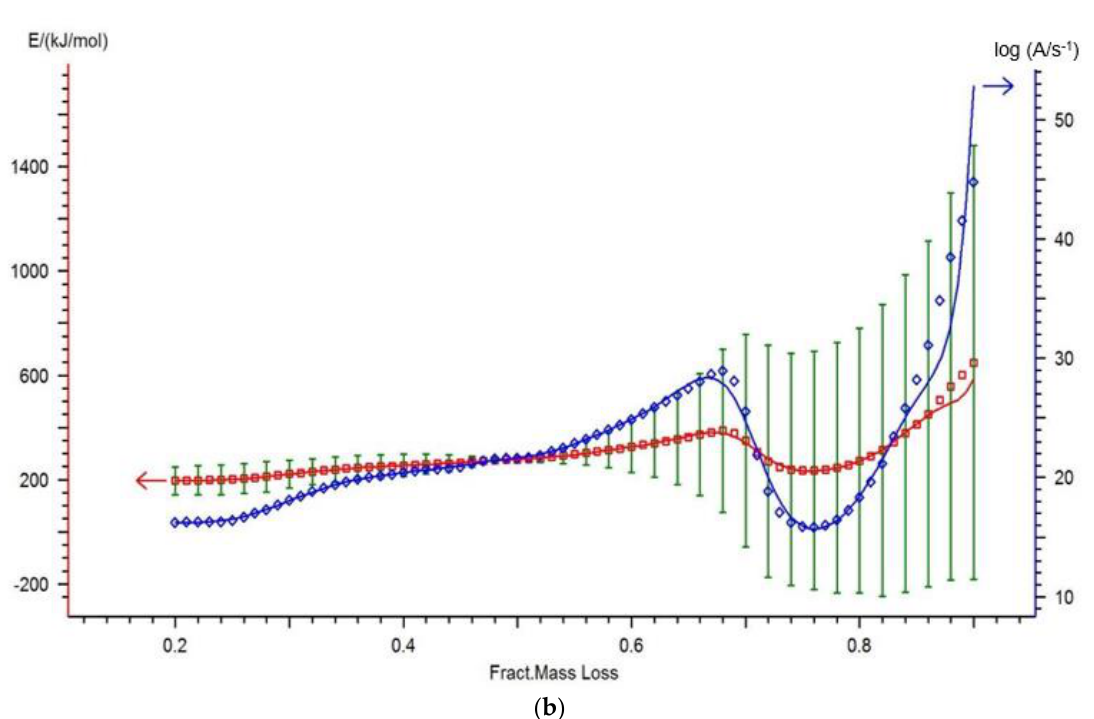
Figure A6. Activation energy (Red color) and pre-exponential coefficient (Blue color) as a function of the conversion degree: ( a ) X = 0.20–0.98, ( b ) X = 0.20–0.90 determined by the Friedman method for sewage sludge. Green color represents the statistical error.